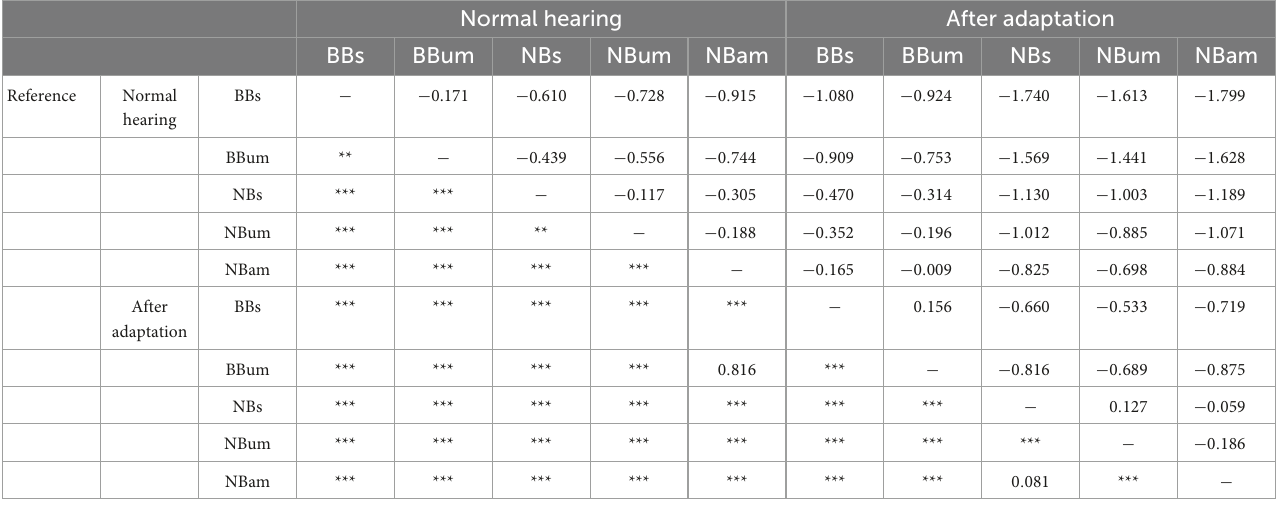
TABLE 4 Generalized linear mixed model comparing different stimuli. Normal hearing After adaptation